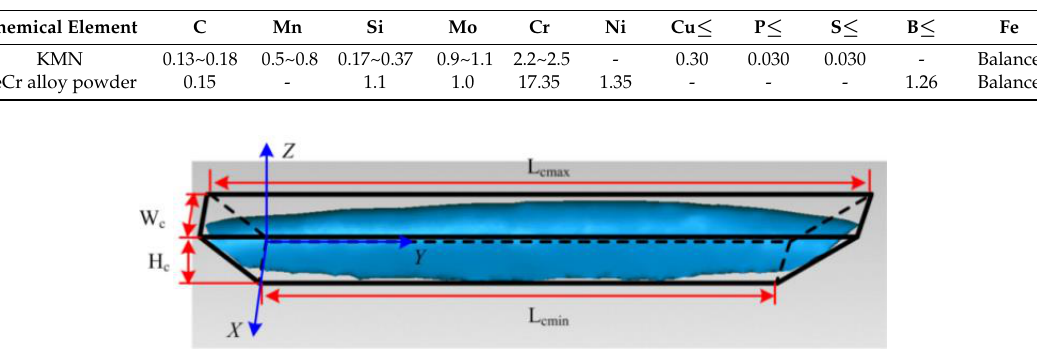
Figure 3. Simplified model of damage position.